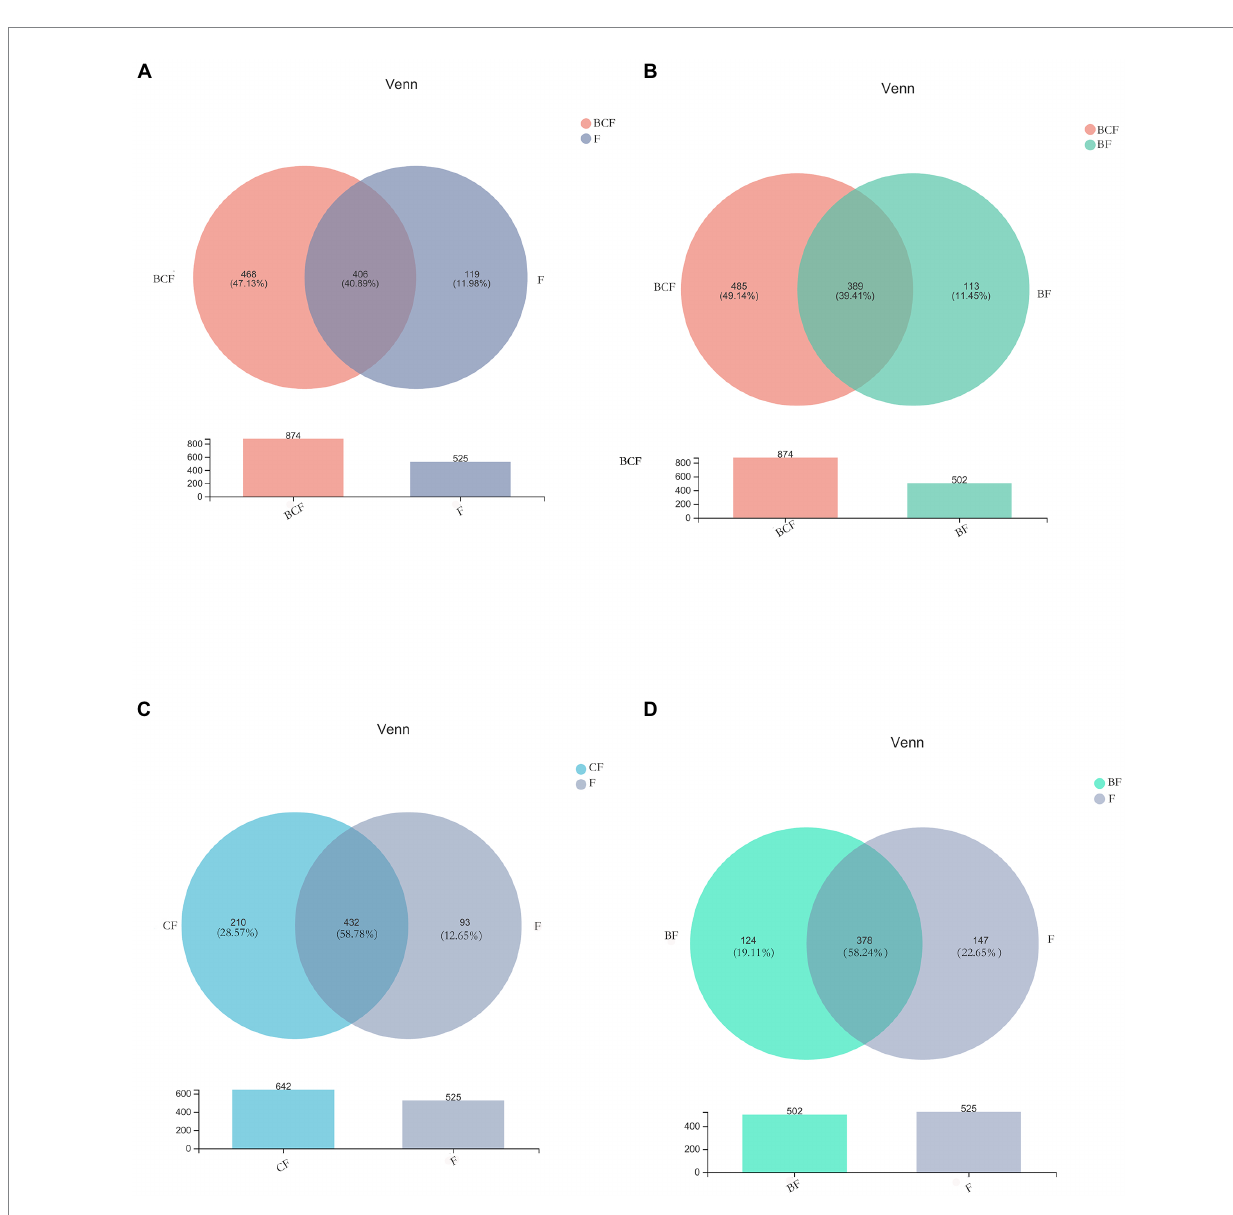
FIGURE 1 Venn diagrams depicting operational taxonomic unit (OTU) distributions in (A) BCF and F, (B) BCF and BF, (C) CF and F, and (D) BF and F